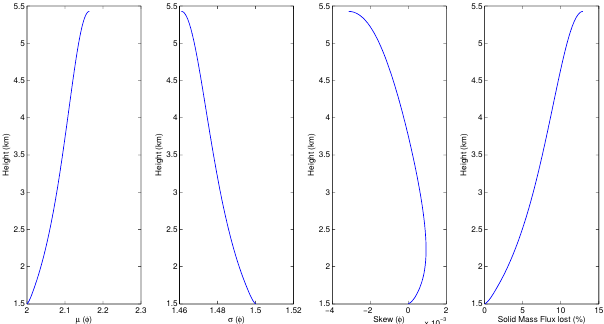
Figure 5. Particle distribution parameters (mean, variance and skewness) and cumulative loss of solid mass flux for the test case 2 (low flux without wind), simulated with the formulation based on the moments of the mass fraction